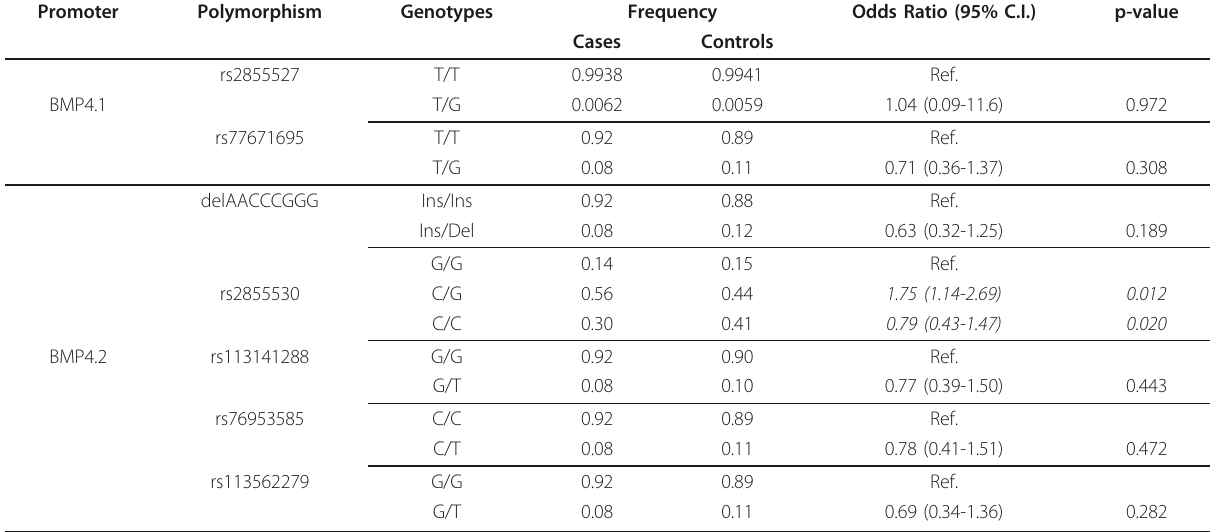
Table 3 Genotype association between BMP4.1 and BMP4.2 polymorphisms and NSCLP.